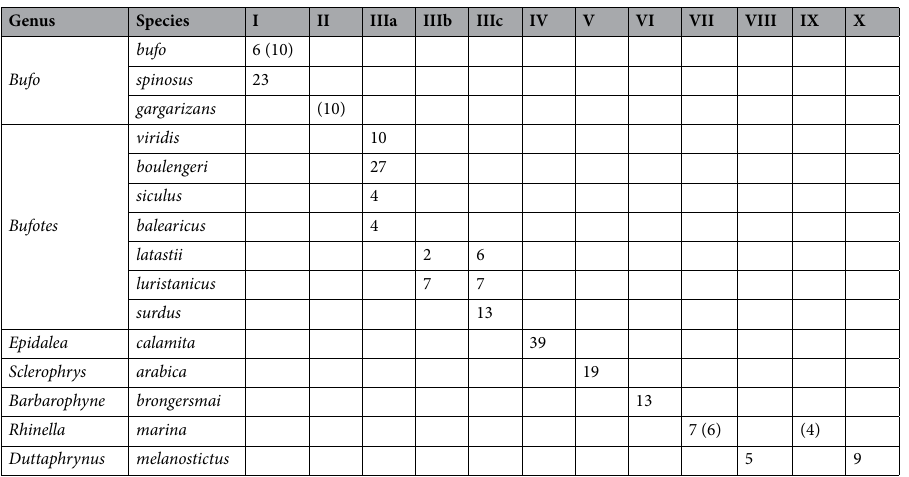
Table 3. Subfamilies/groups of repetitive DNA BamHI-800. Number of sequences found in each group and examined species of Bufonidae. In parenthesis are indicated the number of sequences from assembled genomes included in the